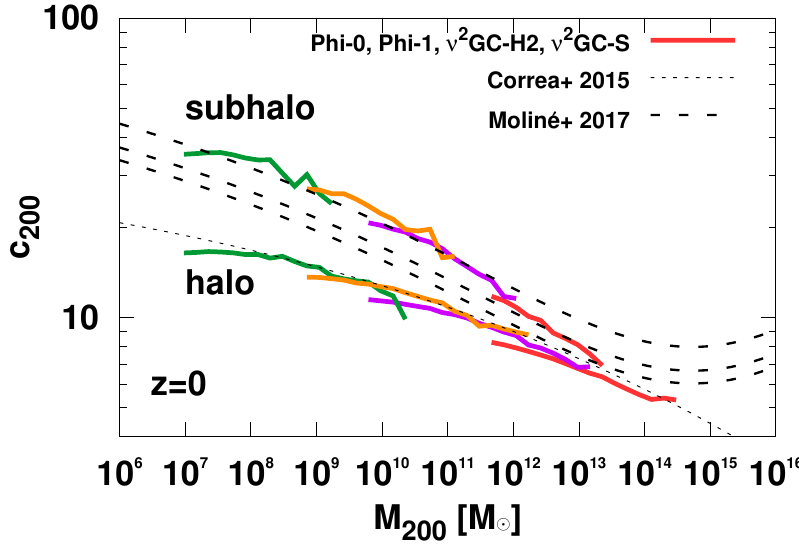
Figure 2. The mass-concentraion relation of halos and subhalos at z = 0, derived from high-resolution cosmological N -body simulations, Phi-0 [67], Phi-1, ν 2 GC-H2, and ν 2 GC-S [50,126,127] (green, orange, purple, and red, respectively). Dashed and dotted curves are fitting formulae proposed by [48,64], respectively. The dependence of the distance to host halo center gives three different dashed